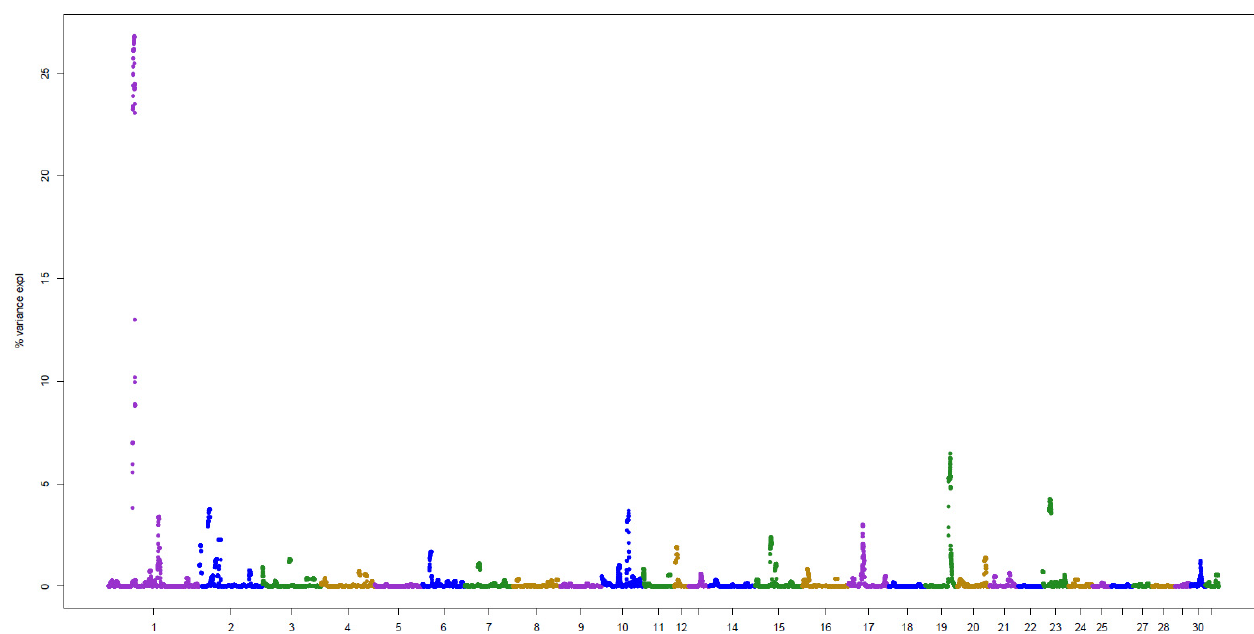
Figure 4. Manhattan plot of hair whorl number on the left side of the neck of Quarter Horses. The y-axis indicates the proportion of variance explained by windows of 100 adjacent SNPs. The chro- mosomes are given on the x-axis.